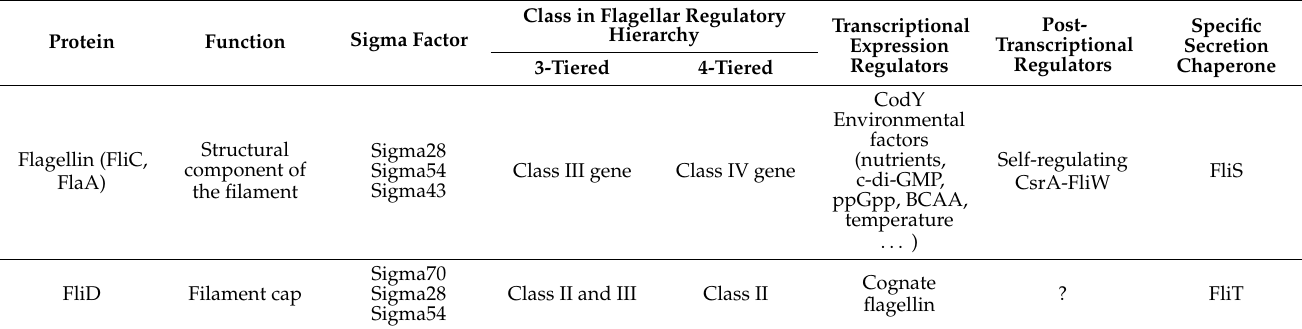
Figure 4. Genetic organization of main flagellar proteins involved in filament formation. The transcription of flagellar genes is hierarchical and controlled by different promoter classes that are temporally regulated. In peritrichous bacteria, flagellar genes are organized into three classes (I–III) and in monotrichous/polar bacteria the flagellar genes are organized into four classes, both starting with the transcription of the class I master regulator (MR*). Red arrows indicate the proteins and/or transcription factors responsible for the transcription activation of each corresponding class of flagellar genes. Black narrow arrows indicate positive activation/induction and black arrows with a vertical line tip (|) indicate inhibition. Genes involved in filament synthesis and their cognate chaperones are represented in italic colored font. Table 1. Flagellins and FliD and their regulators.